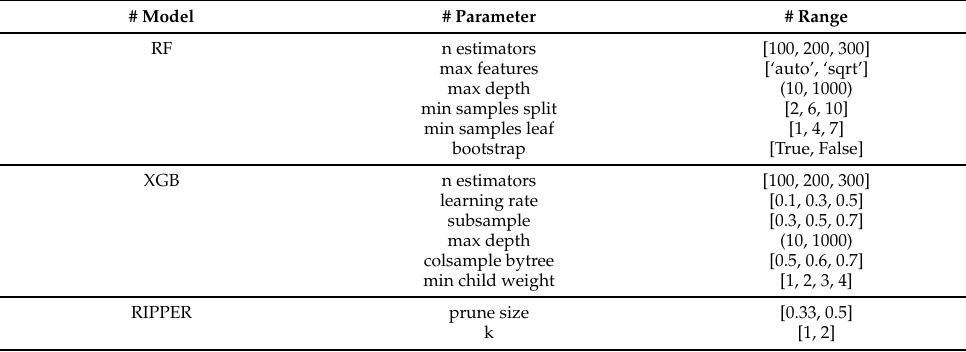
Table 2. Search space of hyper-parameters for the models used in the